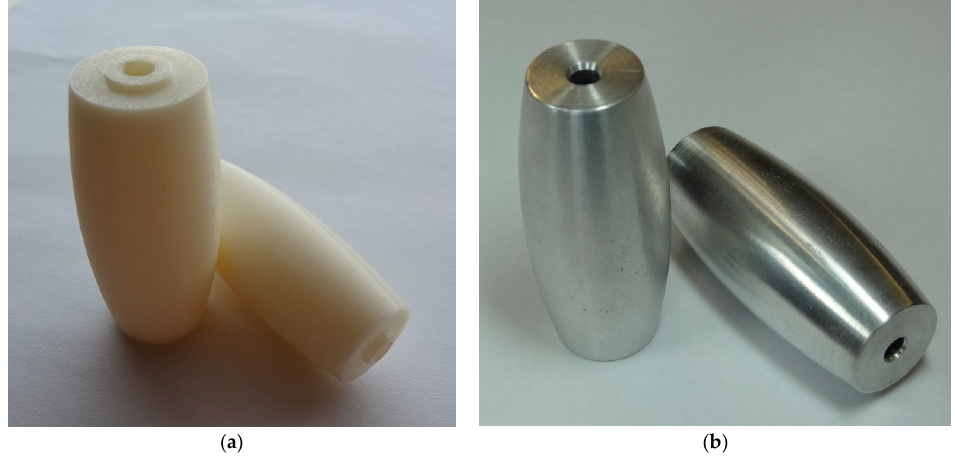
Figure 13. Small passive roller implemented in ( a ) plastic ABS and ( b ) aluminum.